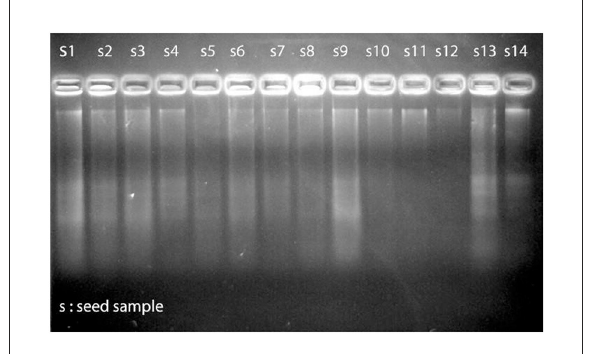
FIGURE4 View of nucleic acids (TNA) obtained from tomato seeds in gel imaging